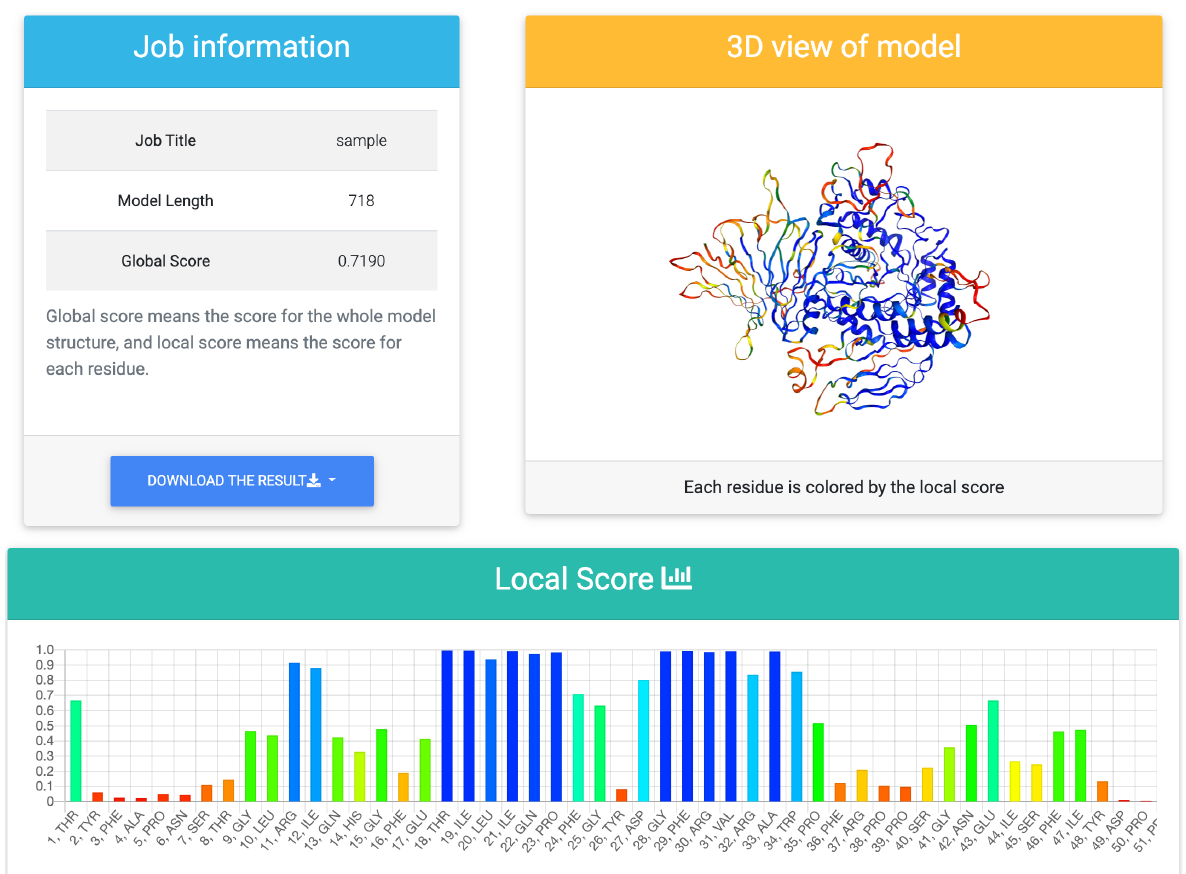
Figure 3. The output page of the prediction results. The predicted score for the whole model, the predicted score for each residue, and the three-dimensional structure colored by the local score is shown. The parts colored in blue represent high local scores, and the parts colored in red represent low local scores. The results can be downloaded in multiple